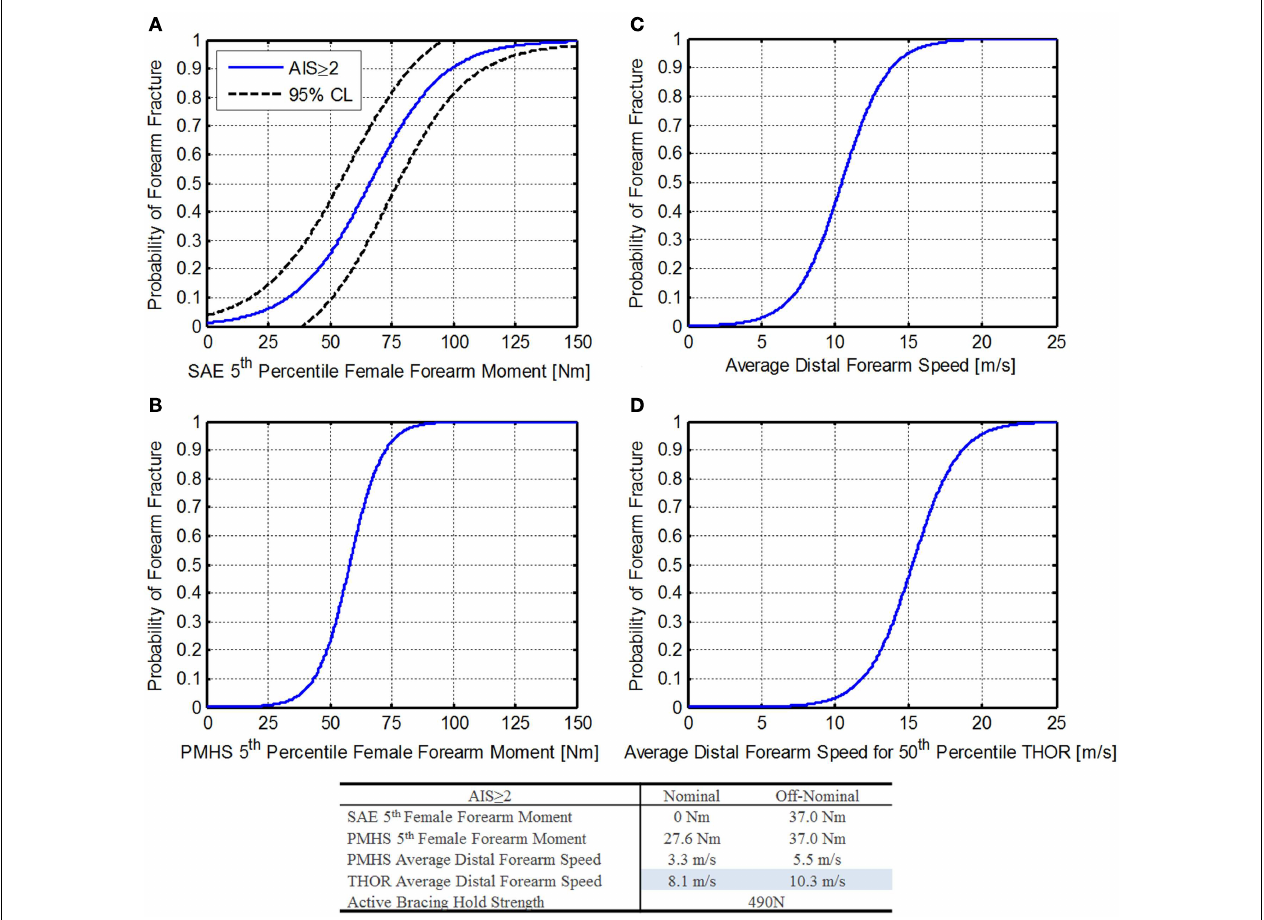
FIGURE 11 | Forearm risk function . (A) SAE fifth percentile female forearm moment (Bass et al., 1997), (B) PMHS fifth percentile female forearm moment (Duma et al., 1999, 2003), (C) PMHS average distal forearm speed (Hardy et al., 1997), and (D) THOR average distal forearm